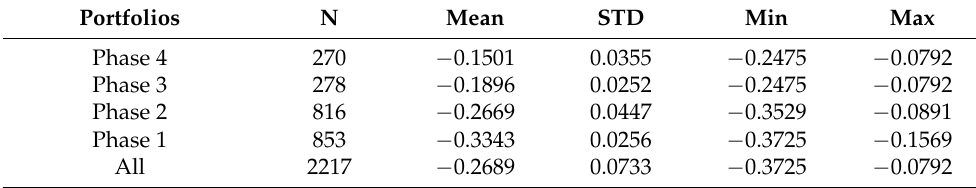
Panel B: Max Drawdown by Portfolio